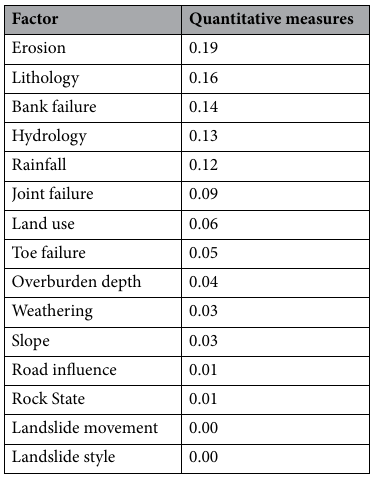
Table 2. Significance of landslide conditioning factors (LCFs) using LASSO